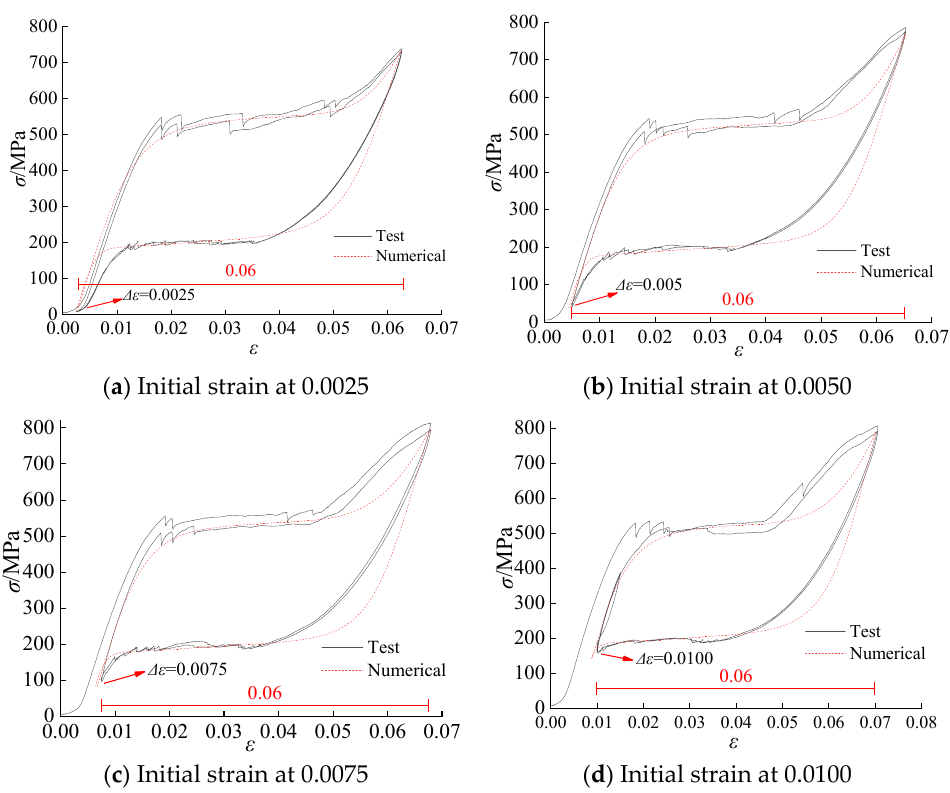
Figure 9. Comparison of test and numerical curves under different initial strain for the pre-tensioned